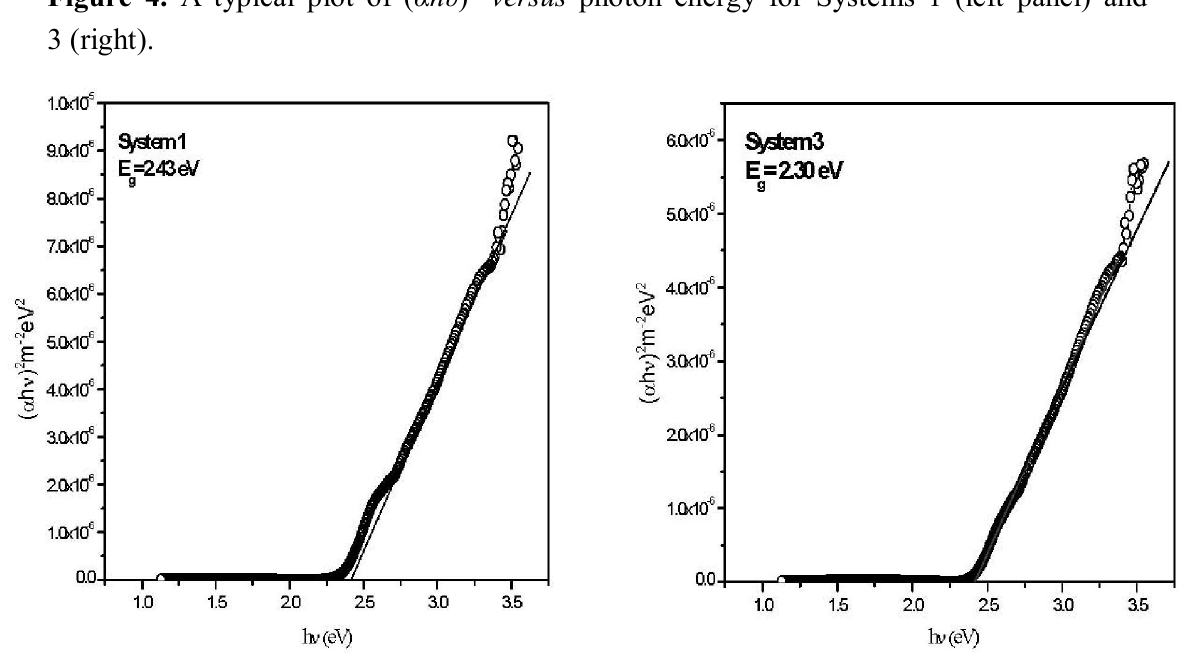
Figure 5. Variation of E